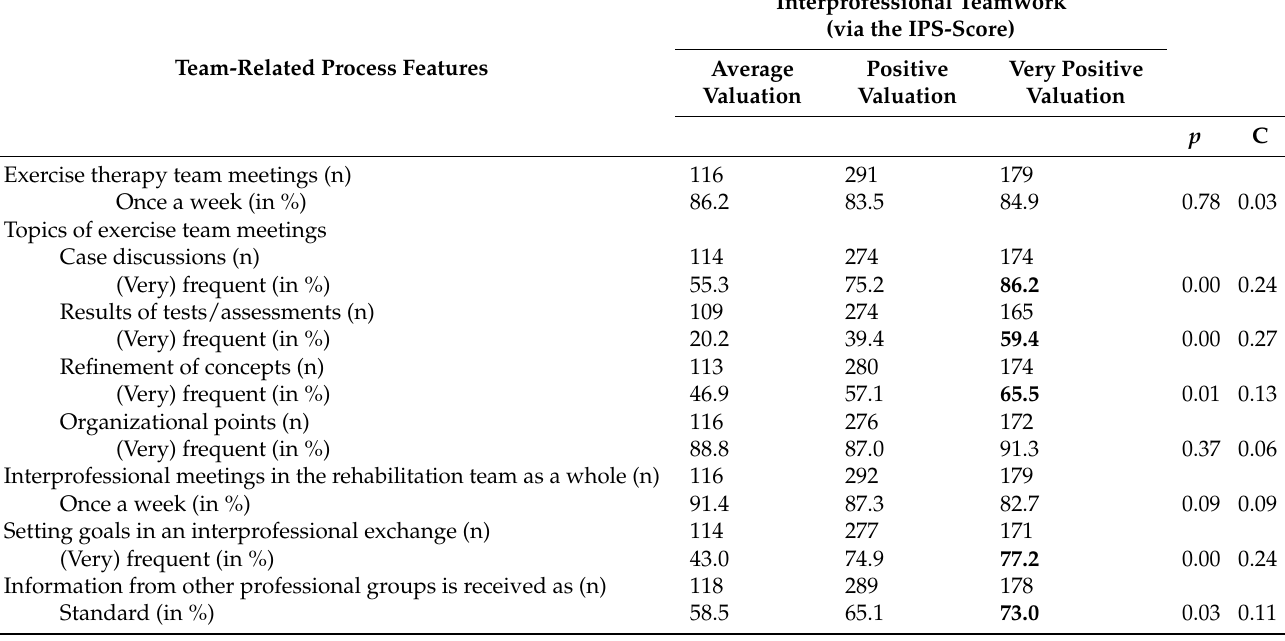
Table 5. Calculated χ 2 tests and contingency coefficient C for correlation analyses between team-related process features and the perceived quality of interprofessional